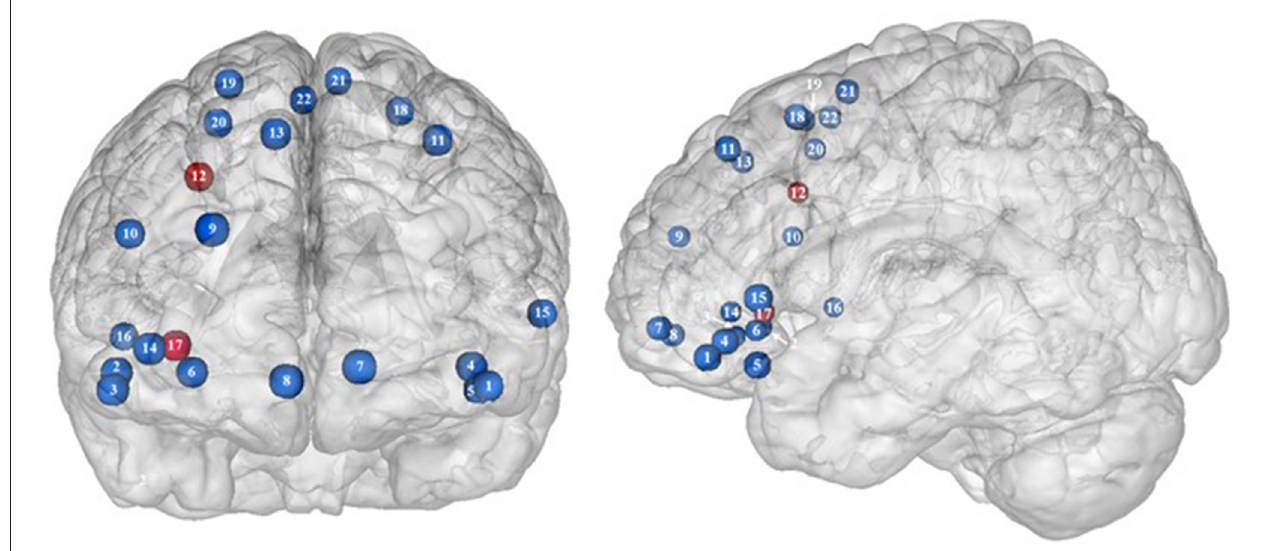
FIGURE 2 | Functional activity in the frontal regions during inhibition. Blue and red colors, respectively, indicate hypo- and hyperactivity, respectively, in obese in comparison with lean participants during inhibition (see Table 2 for precise coordinates). 1–3 = orbitofrontal cortex (43), 4–5 = orbitofrontal cortex (48), 6 = orbitofrontal cortex ( 53), 7–8 = ventromedial prefrontal cortex (43), 9 = dorsomedial prefrontal cortex (48), 10 = dorsolateral prefrontal cortex (53), 11 = dorsolateral prefrontal cortex (50), 12 = dorsolateral prefrontal cortex (52), 13 = dorsolateral prefrontal cortex (43), 14 = ventrolateral prefrontal cortex (43), 15–16 = ventrolateral prefrontal cortex ( 48), 17 = ventrolateral prefrontal cortex (49), 18–20 = premotor cortex (43), 21–22 = premotor cortex (48).